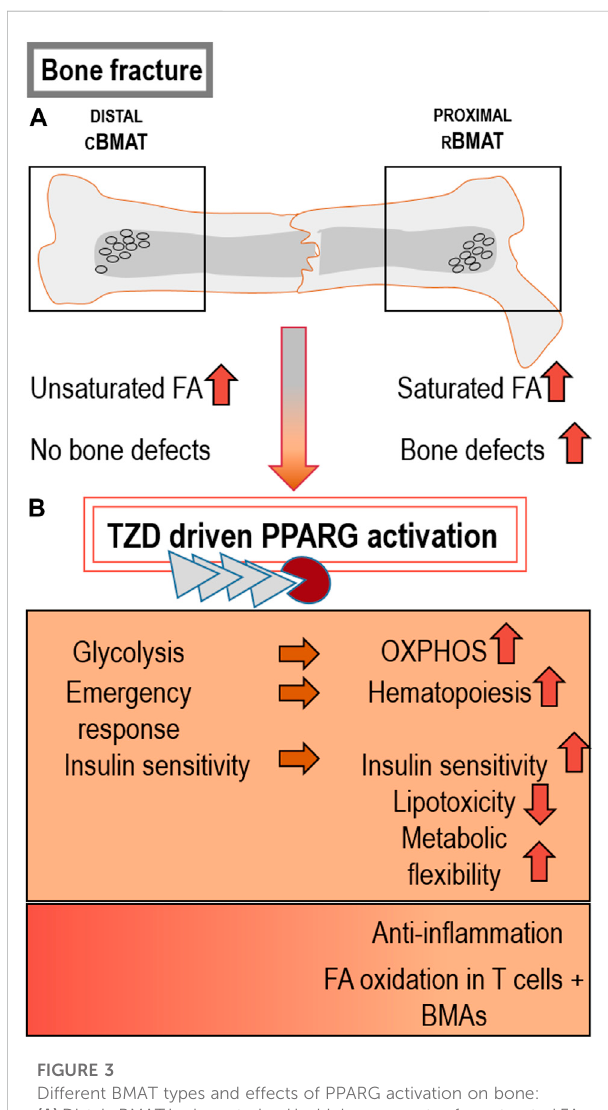
FIGURE 3 Different BMAT types and effects of PPARG activation on bone: (A) DistalcBMATischaracterizedbyhigheramountsofunsaturatedFA and its induction does not normally cause changes in bone health parameters,whereasproximalrBMATnegativelyin fl uencesbone structure and regeneration. This detrimental impact on bone could